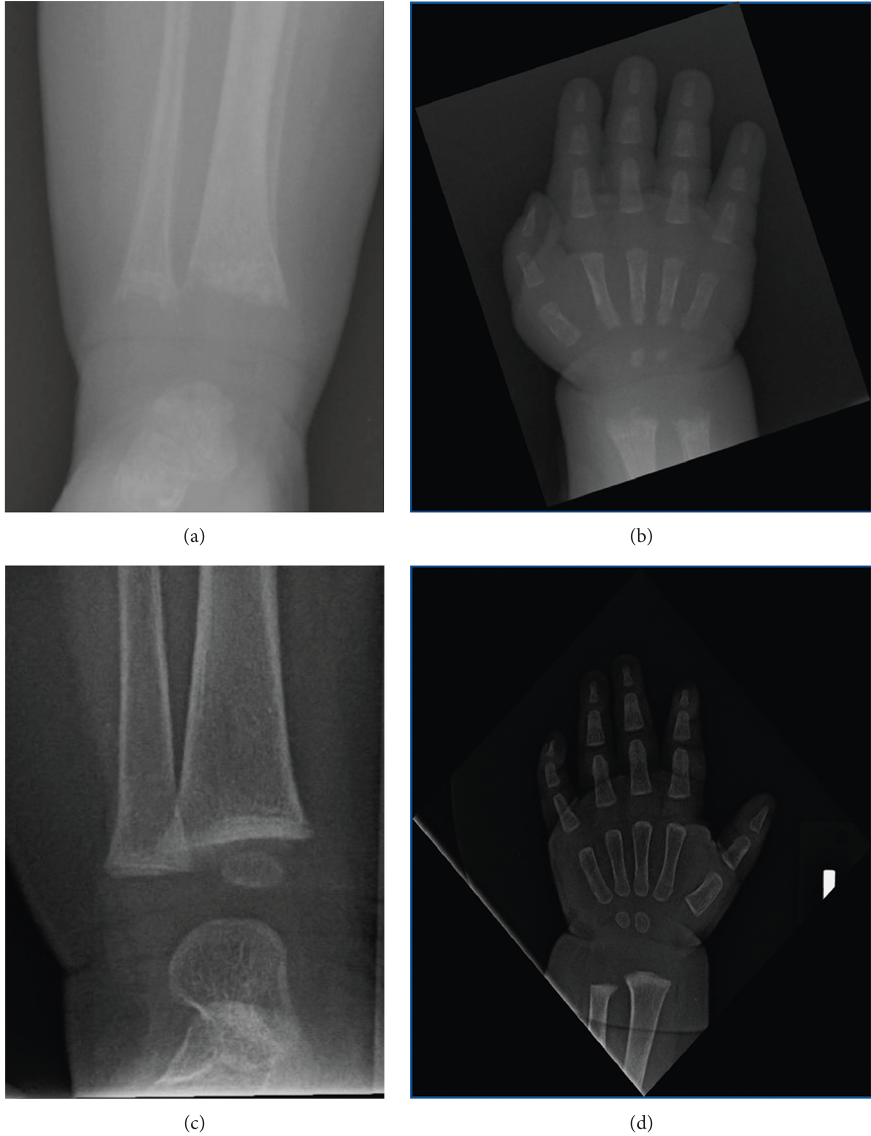
Figure 1: Initial skeletal survey performed at 8 weeks of age demonstrates fraying of the metaphyses of the long bones including the distal tibia (a) and radius and ulna (b). Incidentally note the benign periosteal reaction of the newborn about the tibia. Posttreatment images at 8 months of age (c, d). Only slight cupping of the metaphyses of the tibia (c) and radius and ulna (d)